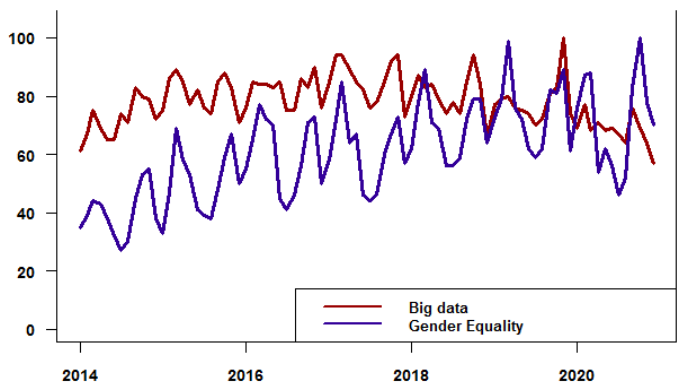
Figure 6. Big Data and SDG 5 global Google trends since